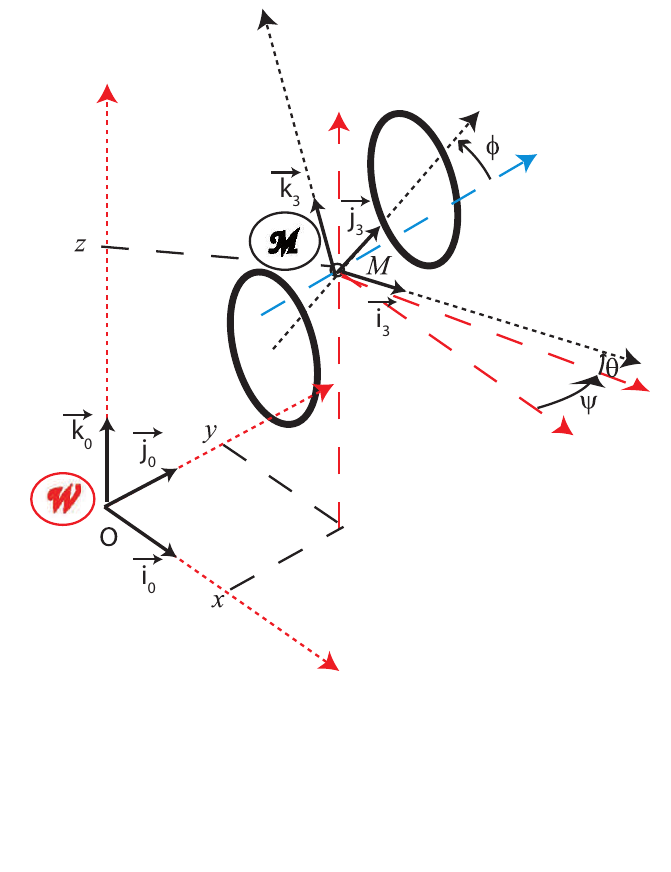
Figure 3. 3D vehicle configuration for a fixed rear axle model, with the world and mobile reference frames as W and M